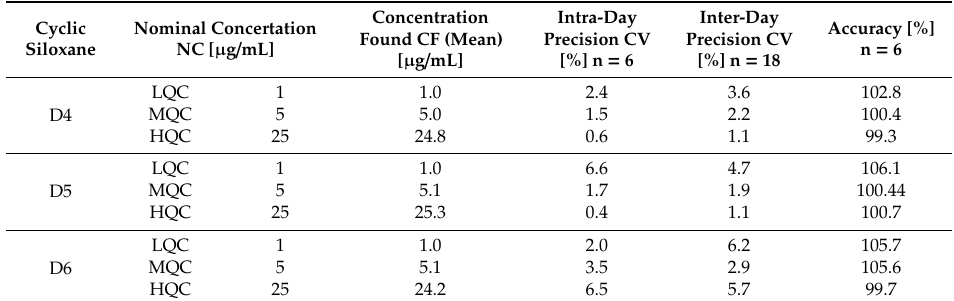
Table 2. Validation results (intra-day precision, inter-day precision, and accuracy) of the analytical method for the determination of D4, D5, and D6 (n = 6 /